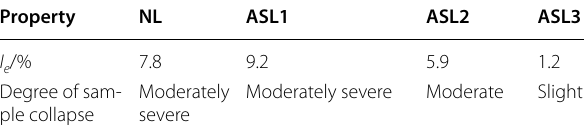
Table 3 Collapsibility test results of the samples